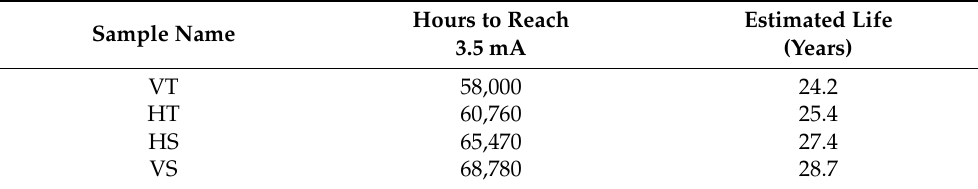
Table 4. Estimated